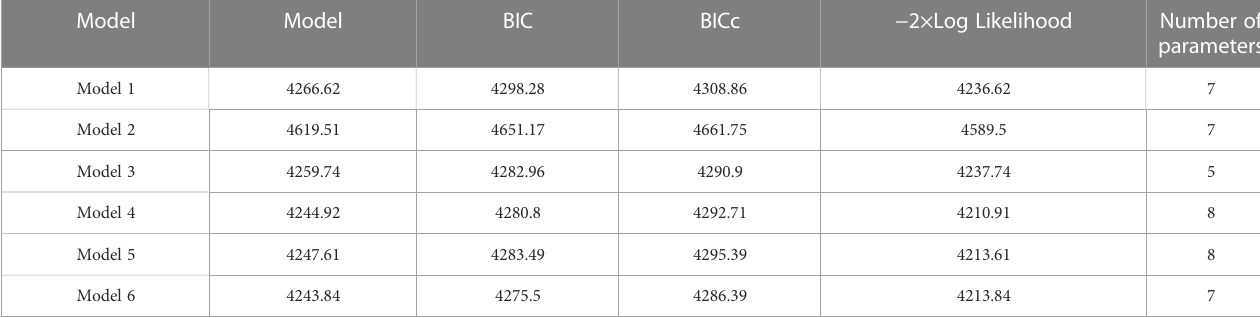
TABLE 1 Model comparison: Estimated information criteria and model performance.